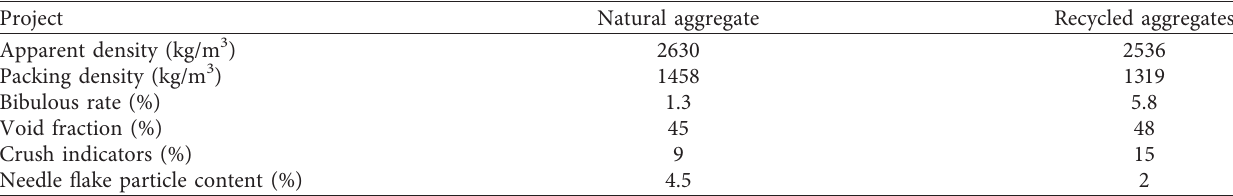
Table 2: Comparison of properties between natural coarse aggregate and recycled coarse aggregate.